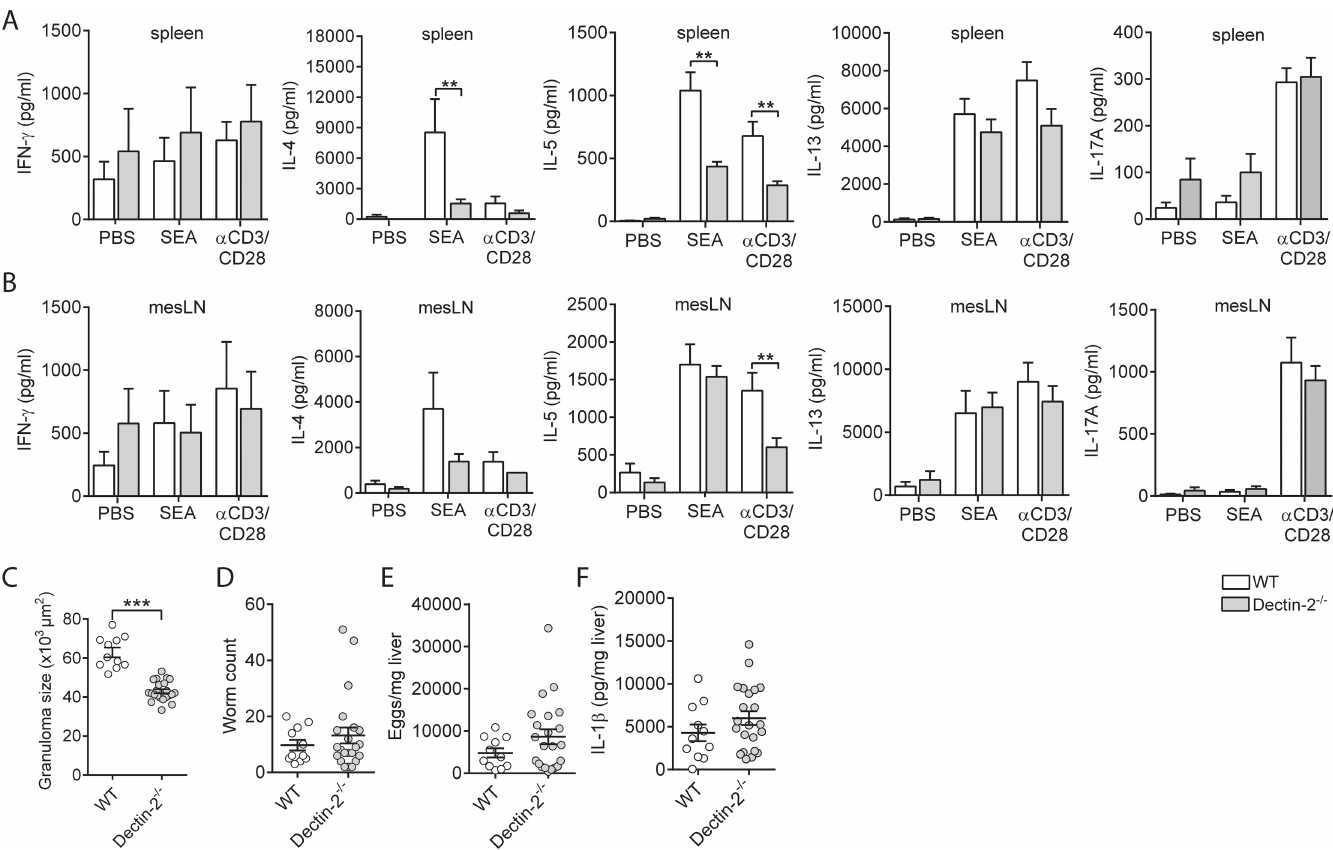
Fig 7. Dectin-2 signaling is required for induction of a Th2 response during S . mansoni infection. WT and Dectin-2 −/− mice were infected with S . mansoni . After 8 wk of infection, cells from spleens (A) or mLNs (B) were restimulated with SEA or anti-CD3/CD28 for 72 h, and cytokine levels were analyzed in supernatants by Luminex or ELISA. Bars represent mean ± SEM of combined data of at least 2 or 3 independent experiments with 5 to 10 mice per group. (C) Granuloma sizes around eggs trapped in the liver of 8-wk–infected mice were assessed in Masson blue–stained liver sections. Data are based on 10 mice per group. Number of worms (D) and liver and intestinal eggs (E) in mice infected with S . mansoni for 8 wk. (F) IL-1 β protein levels in livers of mice infected with S . mansoni for 8 wk. (cid:3)(cid:3) P < 0.01 and (cid:3)(cid:3)(cid:3) P < 0.001 for significant differences relative to the control mice based on unpaired analysis (unpaired Student t test). Underlying data can be found in S1 Data. CD3, cluster of differentiation 3; IL-1 β , interleukin 1 β ; mLN, mesenteric lymph node; SEA, soluble egg antigen; Th2, T helper 2; WT, wild-type.